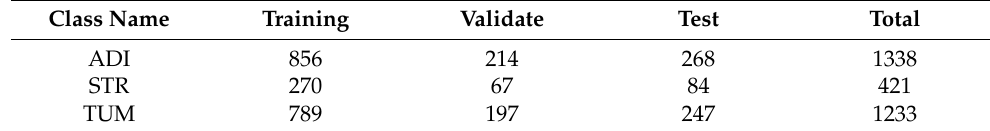
Table 1. The distribution of Colorectal cancer dataset.